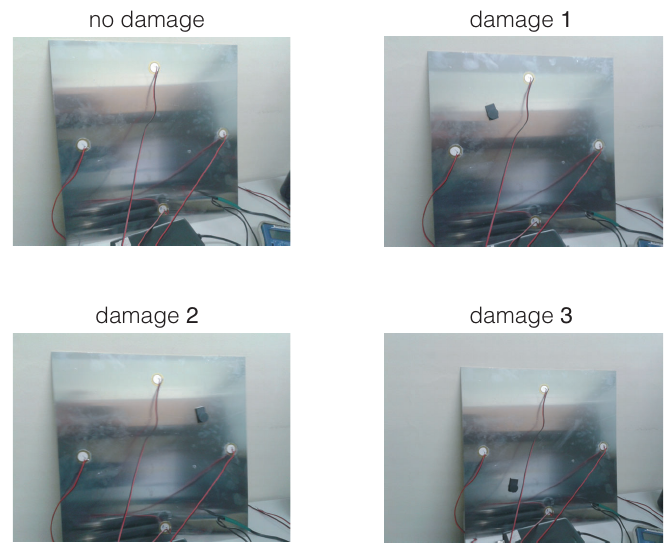
Figure 5. Aluminum plate with four PZTs and with four different structural